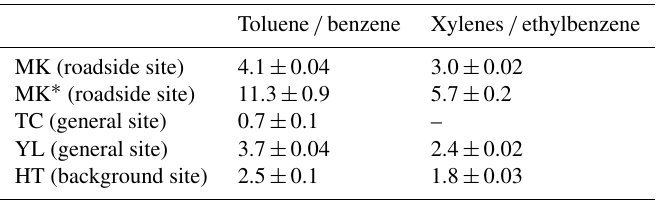
Table 1. Ratios of toluene / benzene and xylenes / ethylbenzene at MK and other sites in Hong Kong from October 2012 to May 2014 (unit: ppbvppbv − 1 ).